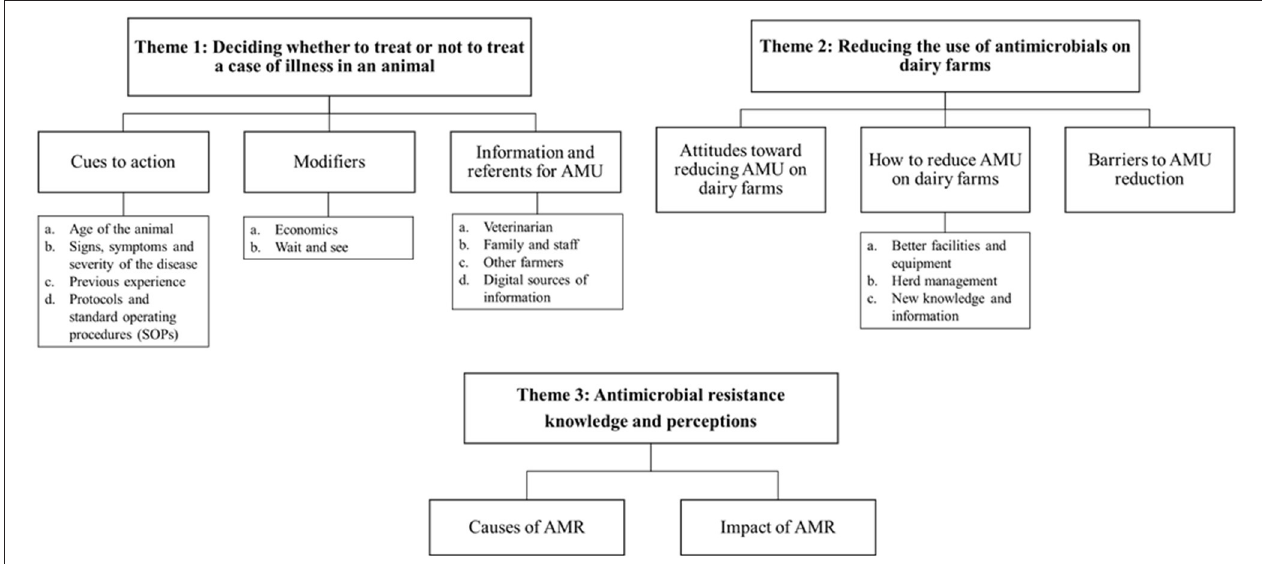
FIGURE 1 | Thematic map of the analysis of data from the seven focus groups of dairy farmers on antimicrobial use in their cattle. AMR, antimicrobial resistance; AMU, antimicrobial